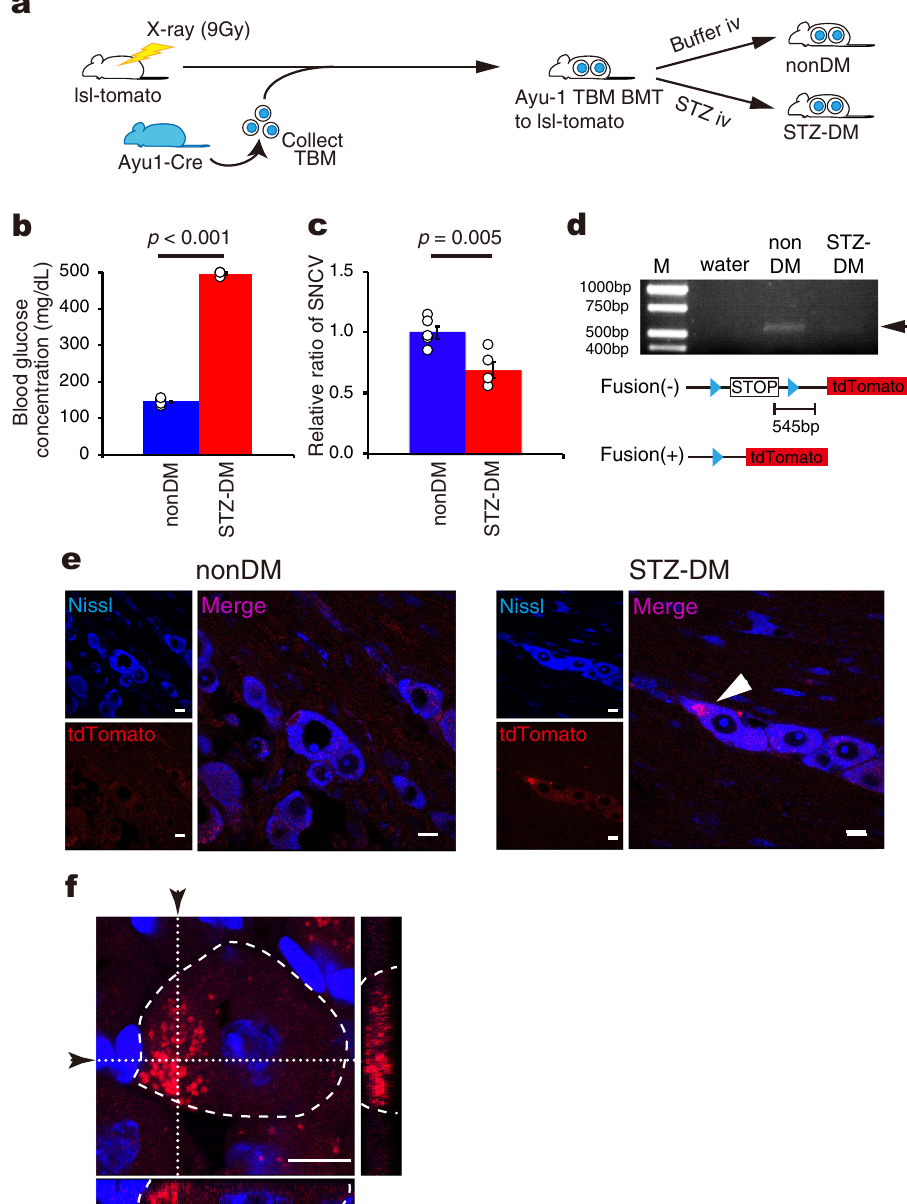
Fig. 1 The detection of Cell fusion in the new bone marrow transplantation model with streptozotocin-induced diabetic mice (Type 1 diabetic model). a A schematic experimental design for a mouse model to detect cell fusion. TBM cells (4 × 10 6 cells) obtained from Ayu1-cre transgenic (Ayu1-cre) mice were transplanted into 9 Gy lethally-irradiated normoglycemic Lox-stop-Lox tdTomato (lsl-tomato) mice (Ayu-1 TBM BMT to lsl-tomato). Four weeks after BMT, Type1 diabetes mellitus was induced by intravenous STZ injection (STZ-DM) while intravenous citrate buffer injection was used as a control (nonDM). b Blood glucose concentration of nonDM ( n = 5) and STZ-DM mice ( n = 4). c Relative ratio of sensory nerve conduction velocity (SNCV) in the sciatic nerve of STZ-DM ( n = 4) and nonDM ( n = 5). d PCR analysis of genomic DNA from DRG neurons. While nonDM showed the presence of a 545 bp showed loxP sites. (We provide the full gel image of electrophoresis as Supplementary Fig. 5.) e Histological analysis of DRG in both nonDM and STZ-DM. Blue showed Nissl stain. Red showed tdTomato. Arrowhead indicates a tdTomato-positive DRG neuron. Scale bars = 10 μ m. f Z-stack imaging of DRG from STZ-DM. Narrow images indicate the cross-section of x -axis or y -axis (whited dotted line) in DRG neuron surrounded by white dashed line. Arrows indicate the position of cross-section. Red showed tdTomato. Blue showed nucleus. Scale bar = 10 μ m. Data are indicated as means ±